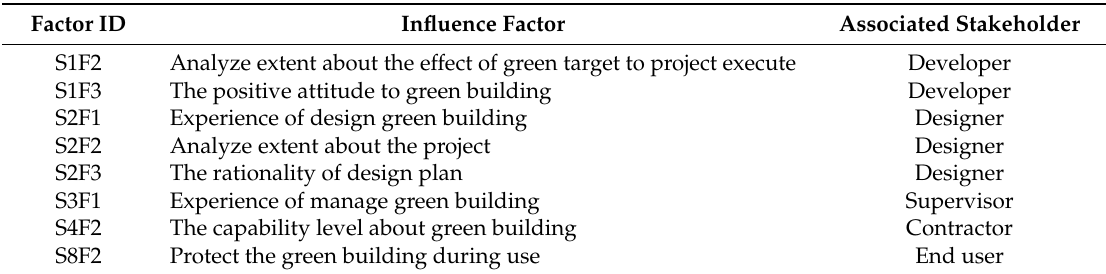
Table 3. Receivers in the influencing factor network.